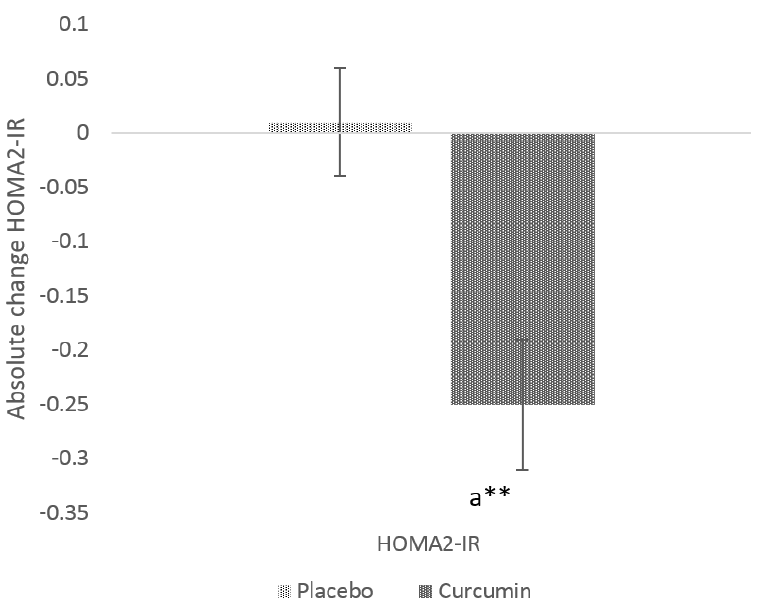
Figure 3. Absolute change in HOMA2-IR from baseline to post-intervention in placebo and curcumin groups for 12 weeks. ** p < 0.01 represents the difference within the treatment group. Small letter (a) represents the significant difference between the treatment groups.